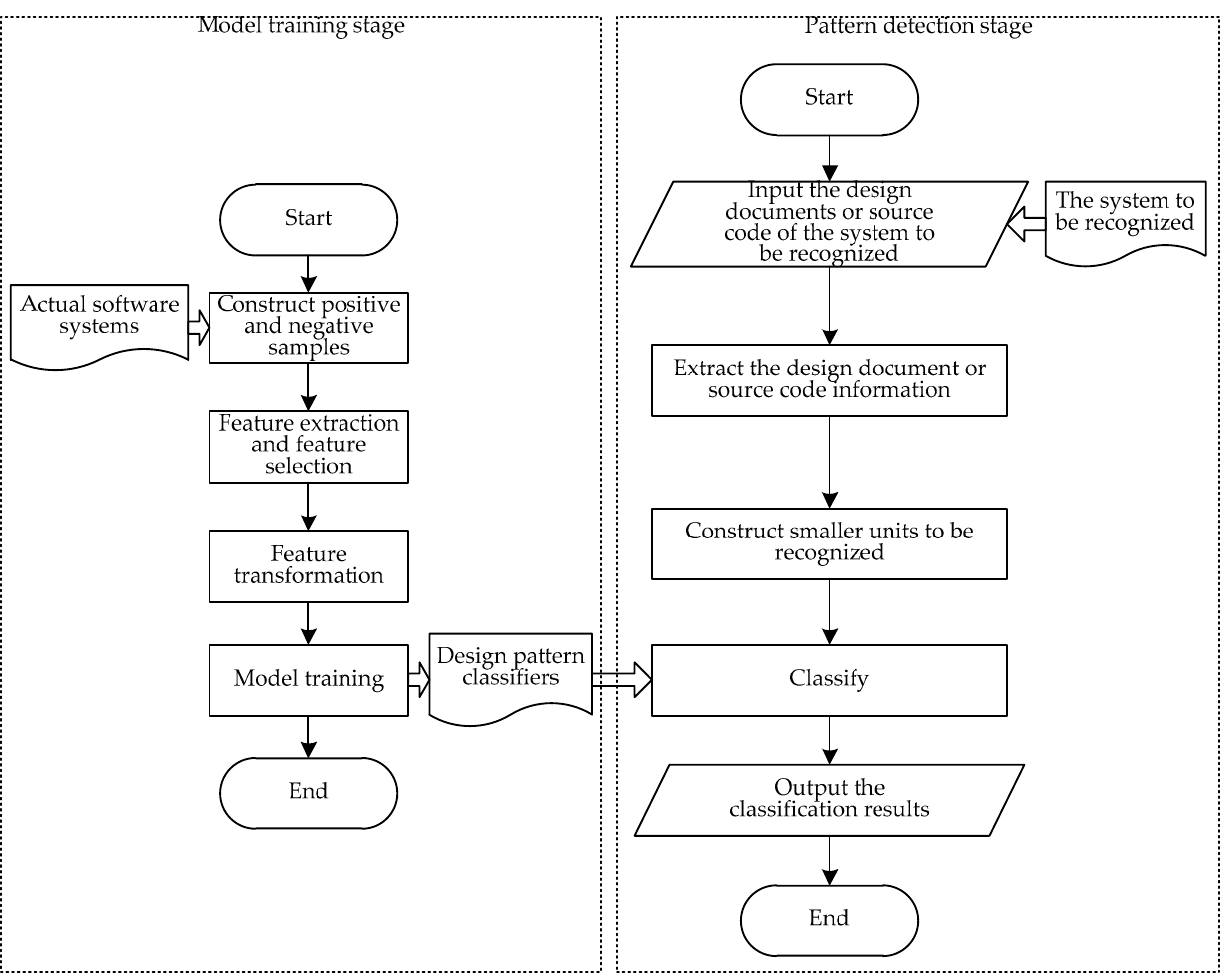
Figure 2. The basic flow of machine learning design pattern detection methods.